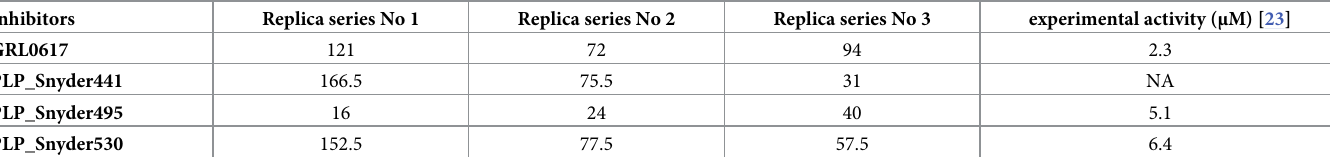
Table 1. The duration times of the unbinding pathways of the inhibitors (ns) with respect to their activity. Inhibitors